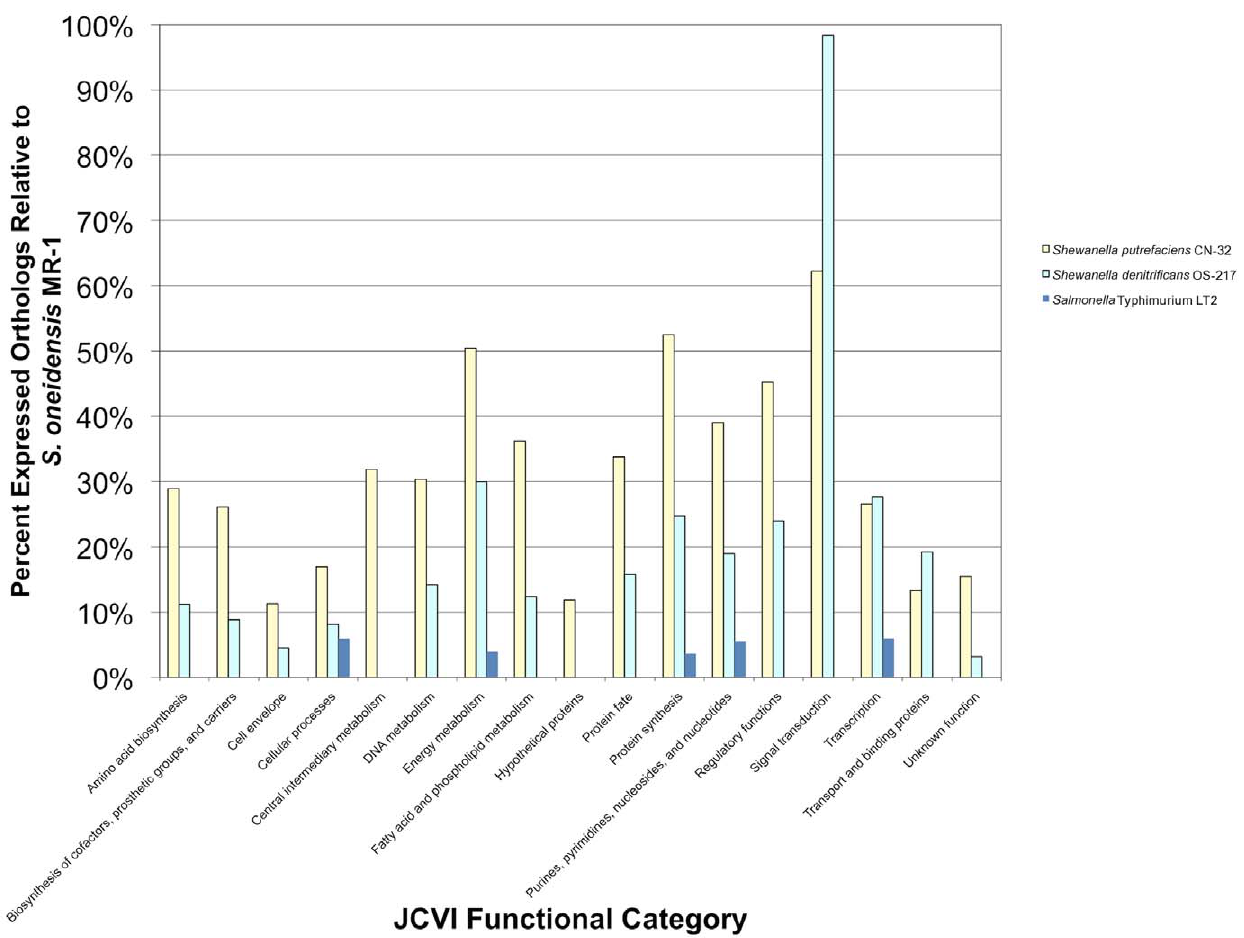
Figure 2. Conservation of functional orthologs across four of the species in the study is displayed, using normalized protein observations. Normalized protein observations were derived by dividing observed proteins for a single species within a category by the total number of proteins observed in the study. S. oneidensis orthologous groups from the JCVI Comprehensive Microbial Resource were employed to examine conservation of function.